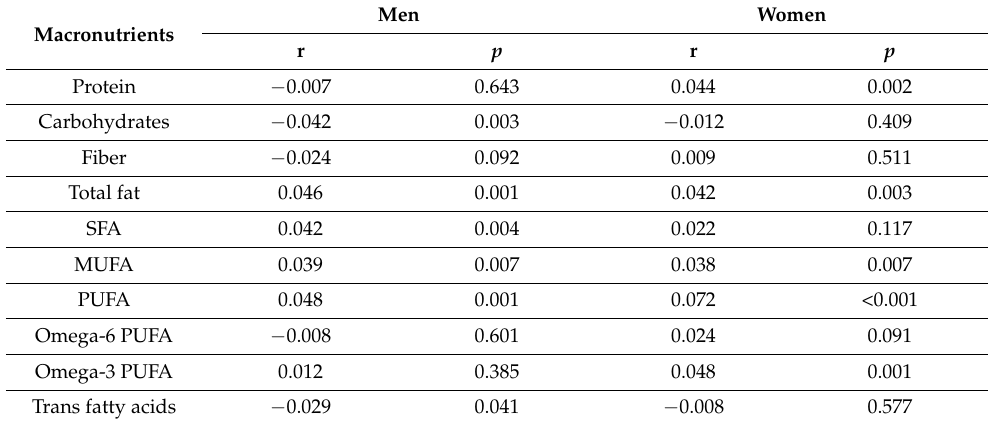
Table 2. Correlation between the ATHLOS Healthy Ageing Scale and macronutrient intake.